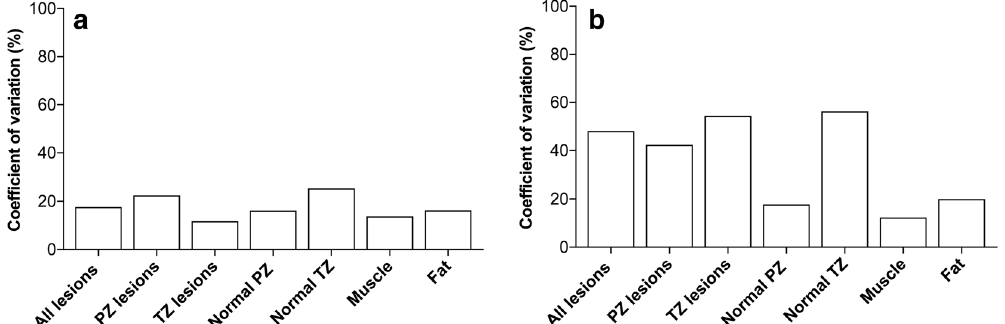
Figure 3. Coefficients of variation of pre-gadolinium ( a ) and post-gadolinium ( b ) MRF T 1 relaxation times obtained from prostate lesions, pooled normal PZ and TZ, internal obturator muscle and subcutaneous abdominal fat. PZ peripheral zone, TZ transition zone, MRF magnetic resonance